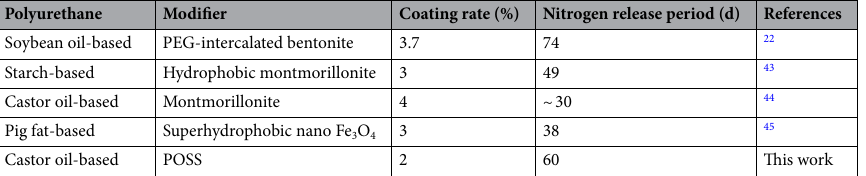
Table 2. The results of PU/1 wt% POSS-PEG nanocomposite (PCU/PEG1) and other nanocomposite coatings for coated